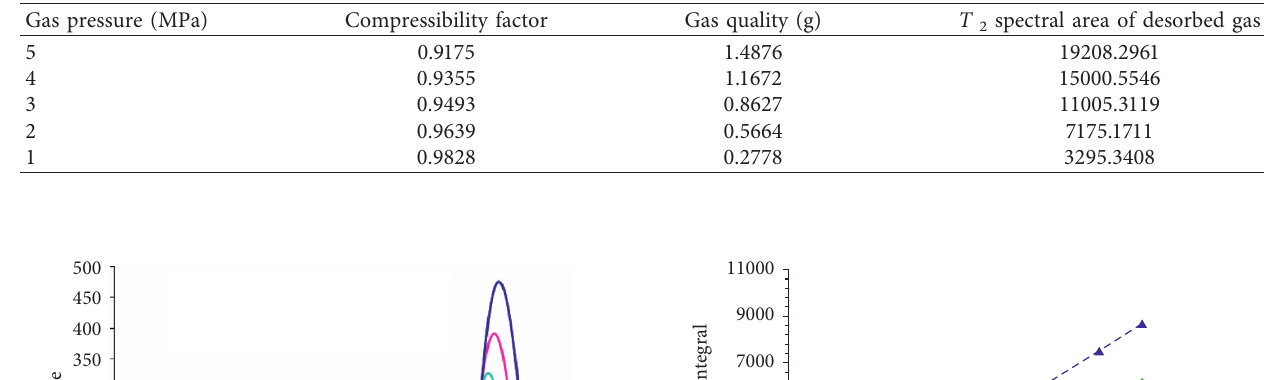
Table 1: Relevant parameters of gas in coal samples under different gas pressures.